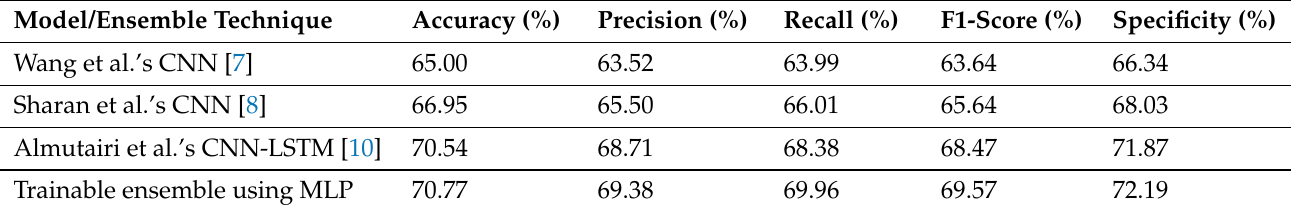
Table 2. Classification performances obtained by considering the raw ECG segments of 1-min time-span. Model/Ensemble